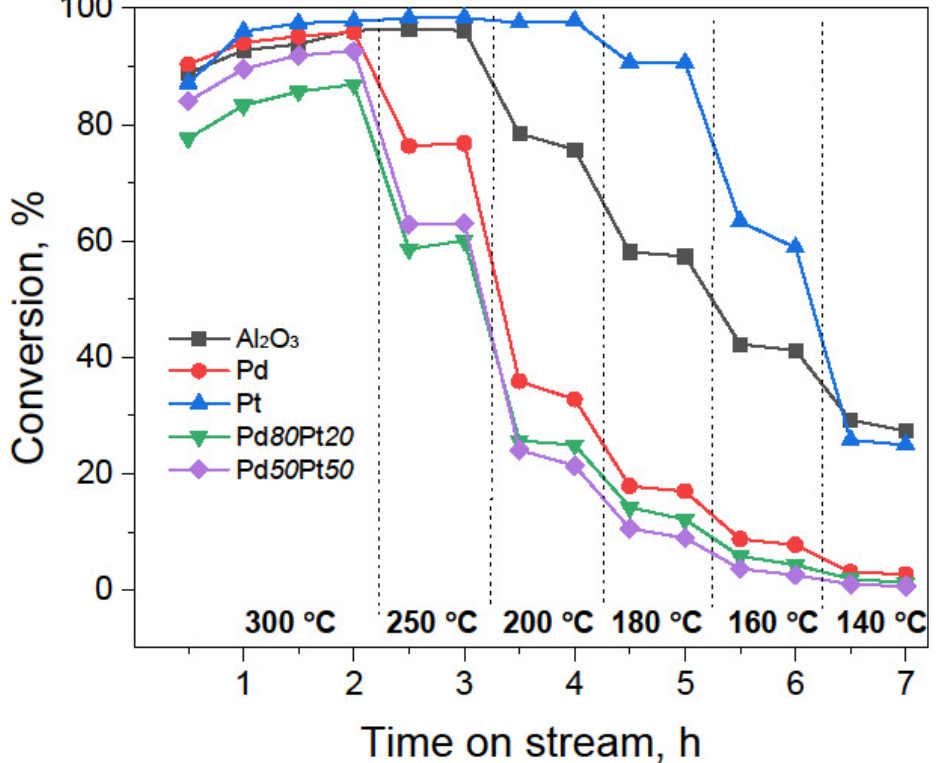
Figure 1. Effect of reaction temperature on the overall conversion of freon R-22 over alumina, Pd/Al 2 O 3 , Pt/Al 2 O 3 and two Pd-Pt/Al 2 O 3 catalysts. Operating conditions: CHClF 2 /H 2 /Ar = 1:8:39, GHSV = 14,400 Ncc/hg cat , P ≈ 1 bar.